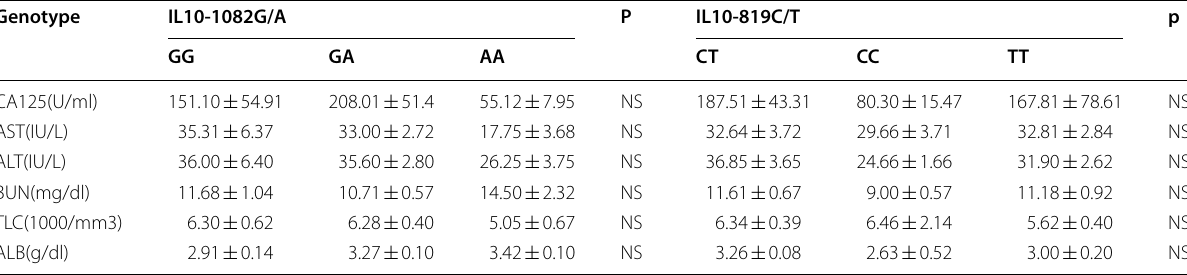
Information is presented as mean SE ± ALT alanine aminotransferase; AST aspartate aminotransferase; CA125 cancer antigen 125; BUN blood urea nitrogen; SE standard error; and TLC total leucocytic count *** P < 0.001, ** P < 0.01, and * P < 0.05